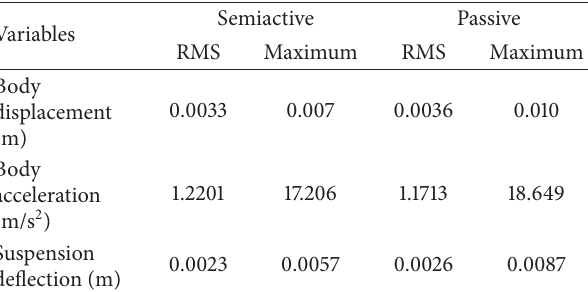
Table 2: Comparison of the performance of semiactive system and passive system for the first